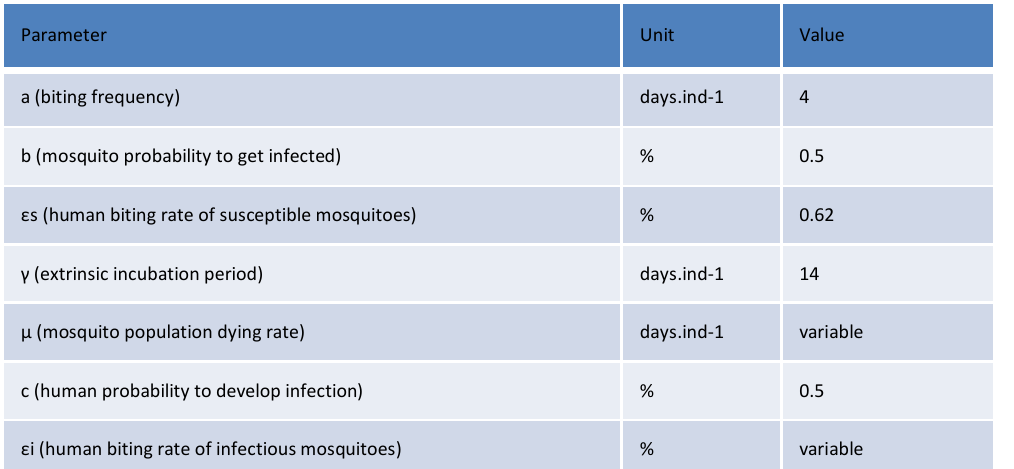
Table S1 : Parameters used in the mathematical